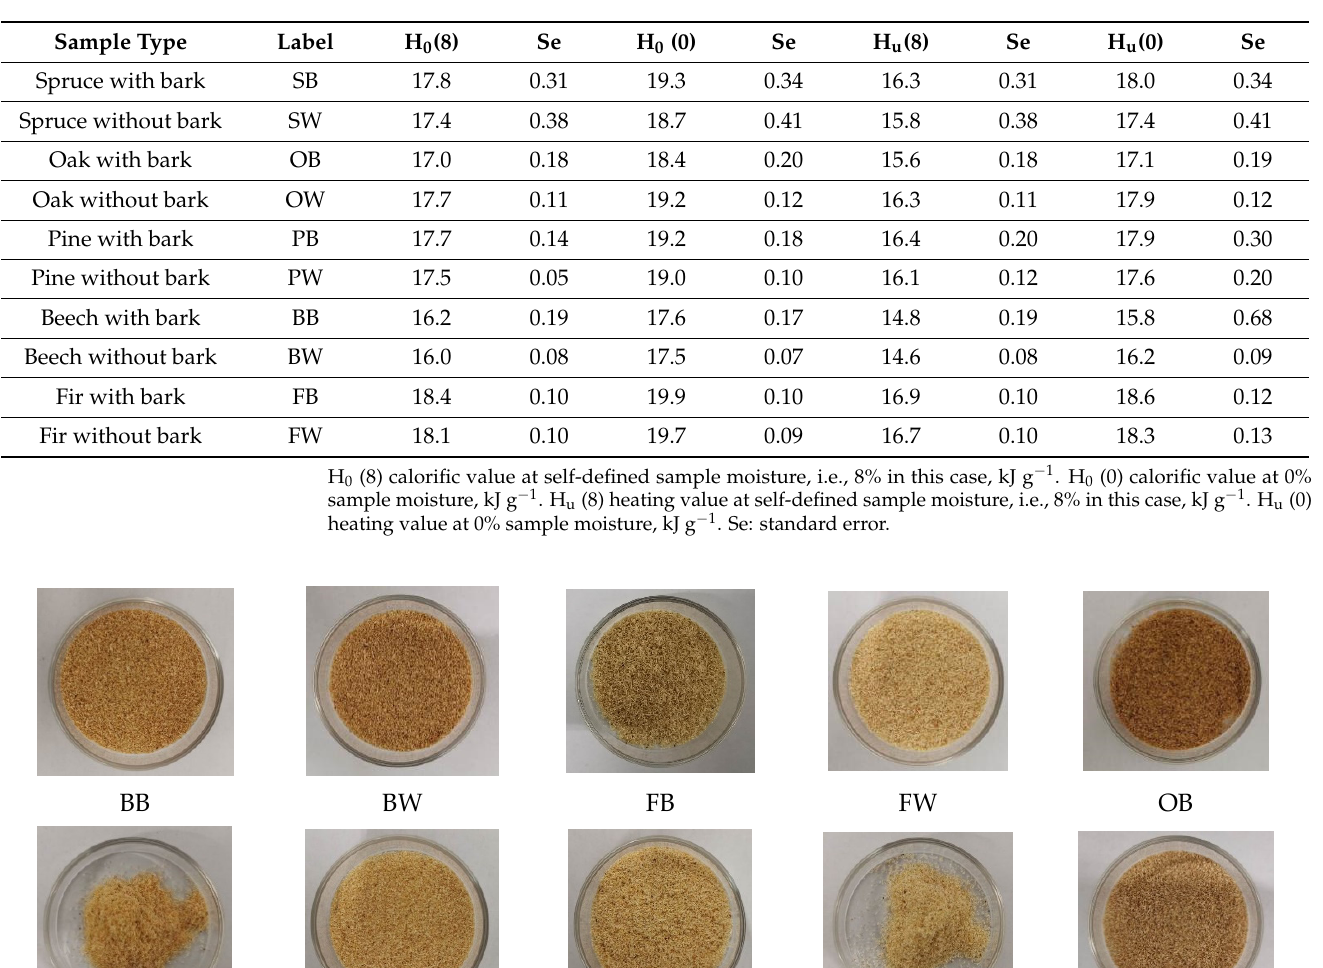
Table 1. Type of wood dust and results from bomb calorimetric.